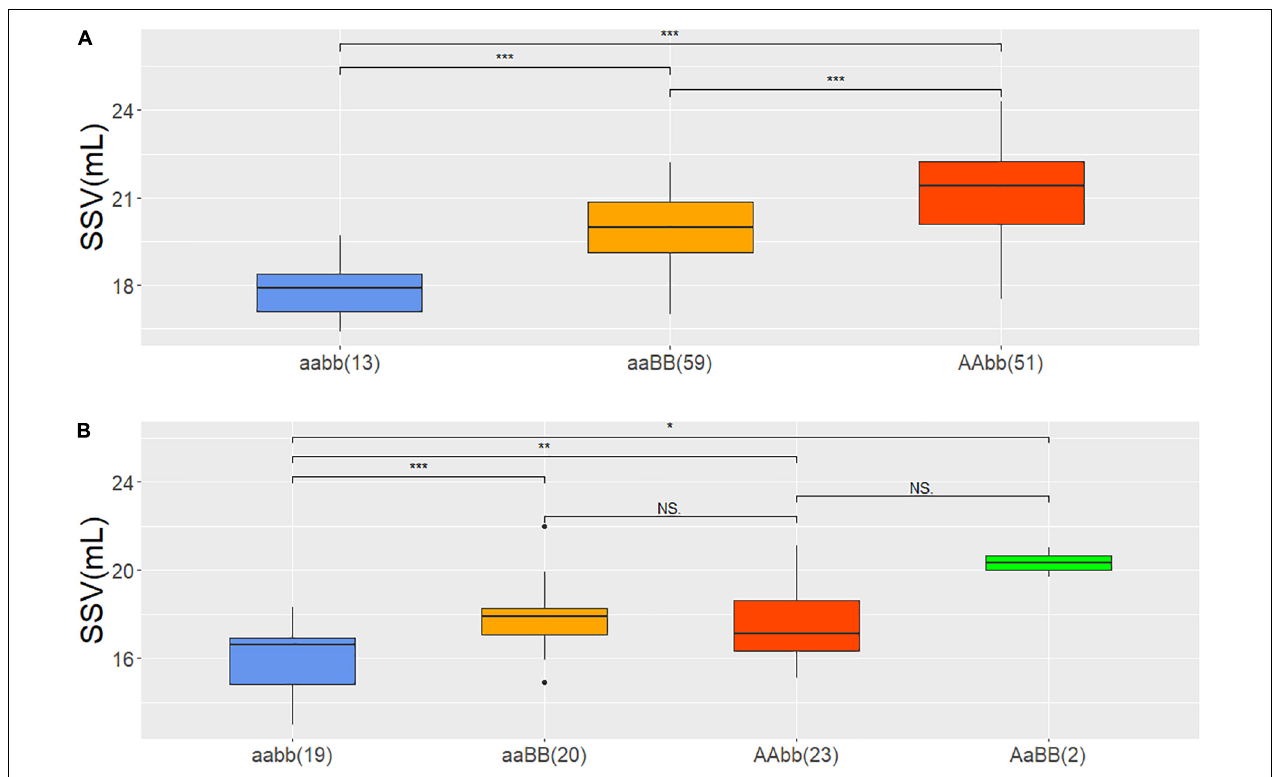
FIGURE 3 | The phenotypic effect of QSsv.cau-1A.1.1 and QSsv.cau-1A.1.2 in the DH and BC 3 F 2 -N populations according to the BLUP value for SSV and the means of SSVs of different types, respectively. (A) DH population; (B) BC 3 F 2 -N population; *, **, and *** indicate significant differences at the.05, 0.01, and.001 levels, respectively (Student’s t -test). aabb: QSsv.cau-1A.1.1 carrying homozygous alleles from LX99 and QSsv.cau-1A.1.2 carrying homozygous alleles from ND3753; aaBB: QSsv.cau-1A.1.1 carrying homozygous alleles from LX99 and QSsv.cau-1A.1.2 carrying homozygous alleles from LX99; AAbb: